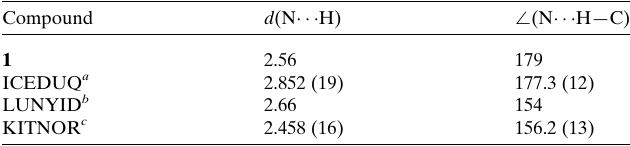
Table 2 Comparison of N (cid:2)(cid:2)(cid:2) H—C contacts (A˚ , (cid:4) ) observed in 1 and selected other